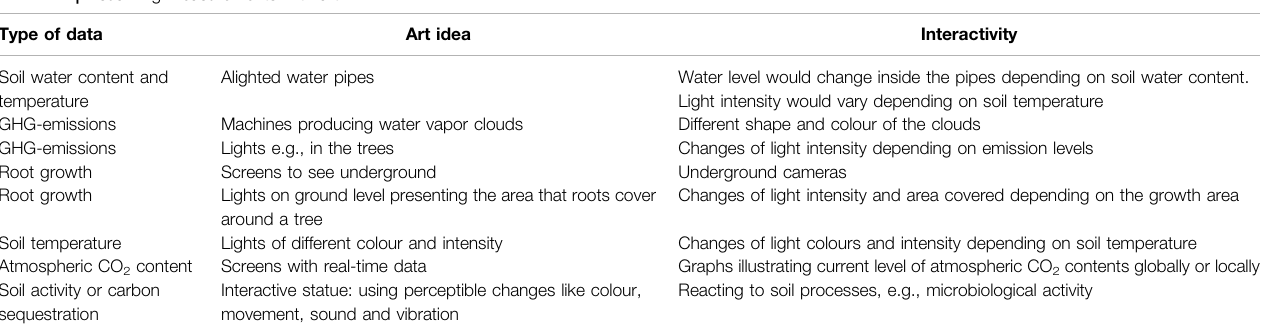
TABLE 2 | Visualizing measurements with